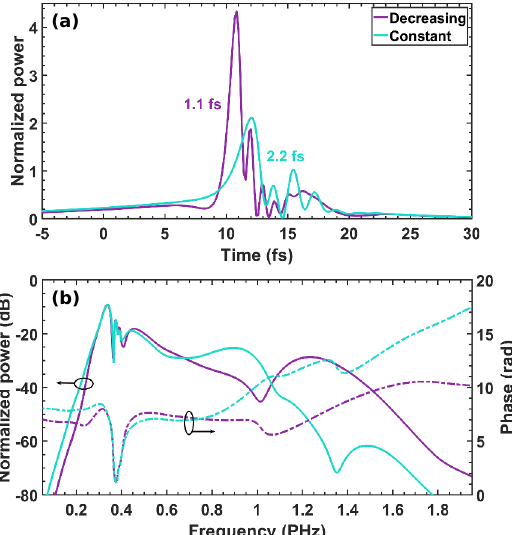
Figure 2. (a) Output pulses and (b) their corresponding spectra obtained after the propagation of a 80 µ J, 30 fs gaussian pump pulse at 800 nm through a 3 m long, 100 µ m core radius HCF homogeneously filled with argon at 200 mbar (cyan) and with its equivalent decreasing pressure gradient ending in vacuum (pur- ple). In both plots, the power is normalized to its initial peak value and the labels next to each pulse in (a) stand for the FWHM output